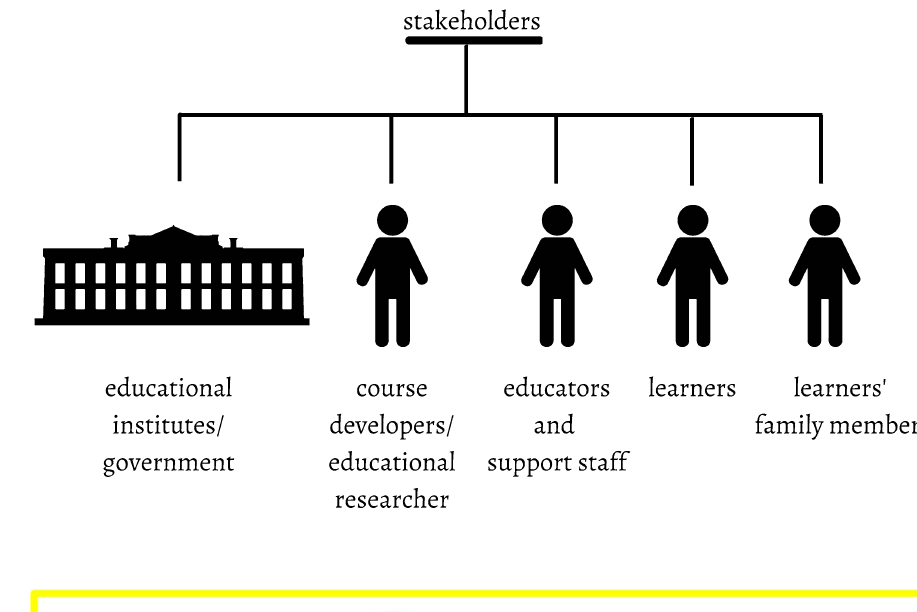
Fig. 3 Benefits of online